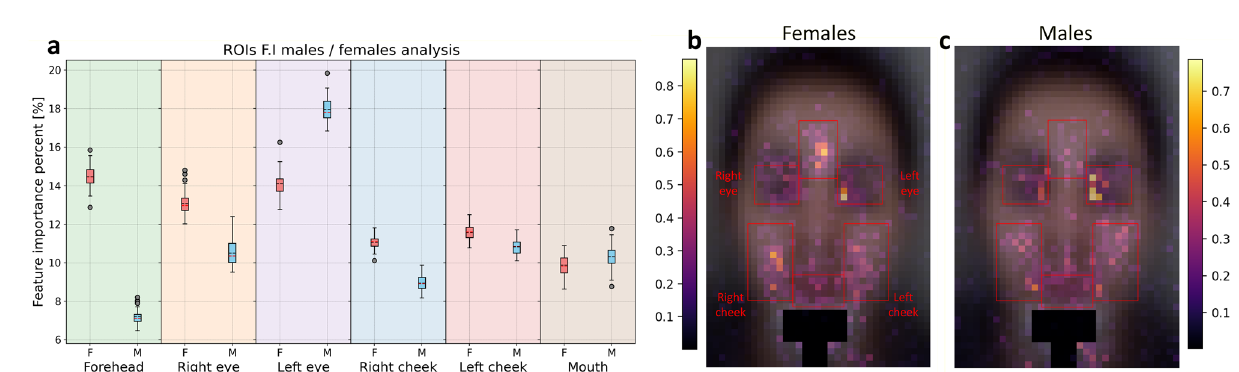
Figure 4. Facial regions of importance (ROIm) analysis per gender (OvO multiclass, 110 LOOCV iterations). (a) Spatial feature importance summary for females (b) and males (c), achieved by performing training with each gender data